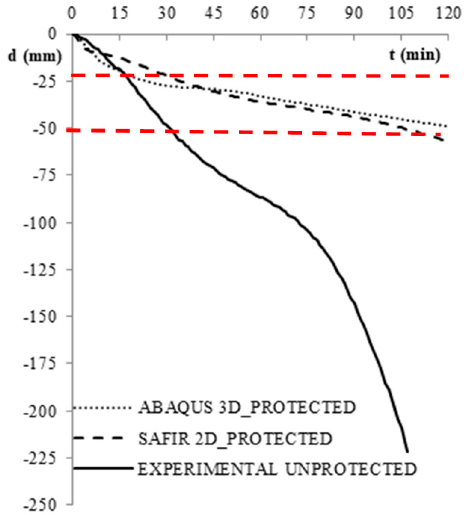
Figure 12. Effectiveness of Intumescent Coating: predicted deflection for protected slim floor vs. recorded deflection for the unprotected slim floor, WFRC 66162.